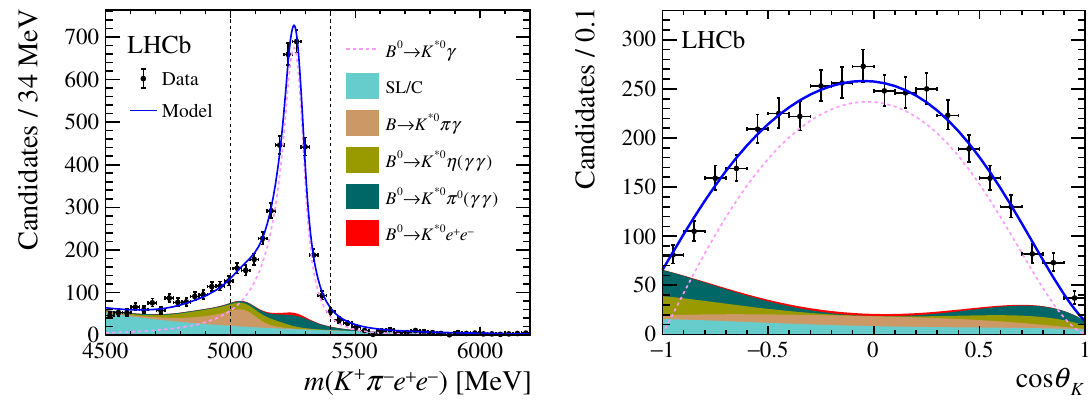
Figure 2 . Distributions of the (left) K + π − e + e − invariant mass and (right) cos θ K of B 0 → K ∗ 0 γ candidates. The black points represent the data, while the solid blue curve shows the total PDF. The signal component is represented by the dashed pink line and the shaded areas are the background components, as detailed in the legend. The SL/C component is composed of semileptonic and combinatorial background contributions. The dashed vertical lines indicate the restricted mass range used in the angular